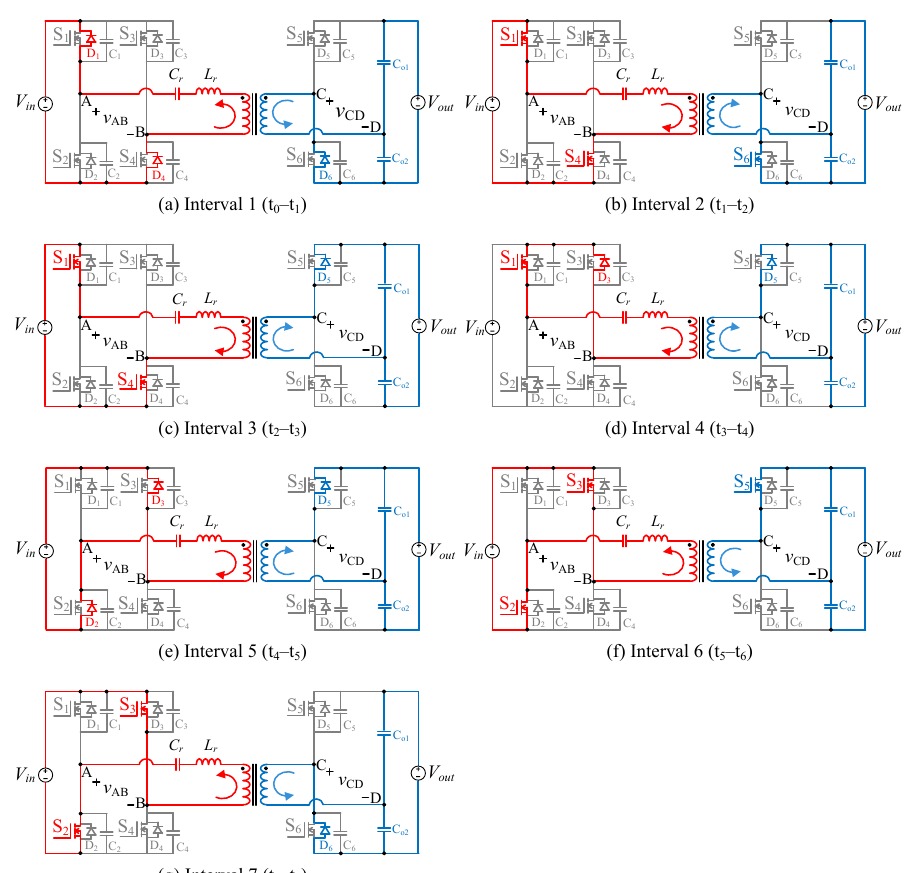
Figure 3. Equivalent circuits during different time intervals in forward